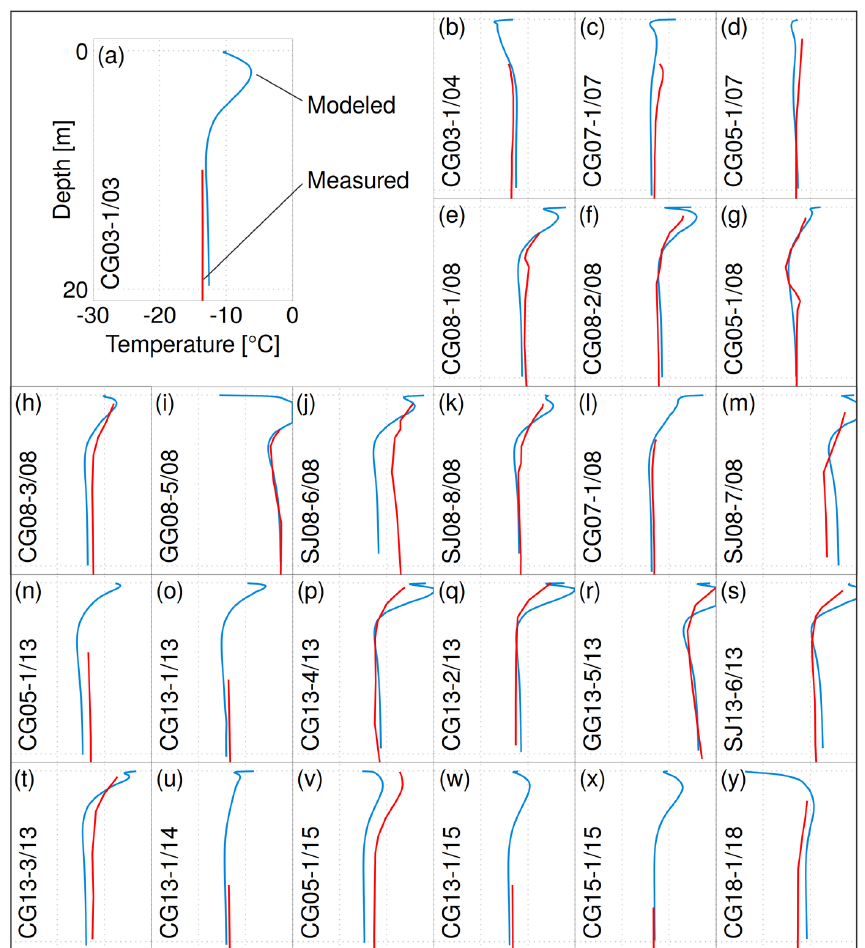
Figure 4. Measured and modeled borehole temperature profiles, sorted chronologically. Axis range is the same in all plots. The bottom depth of 20m corresponds to the deepest simulated values and to the depth of zero amplitude of the annual cycle. Profile codes follow the scheme XXYY-Z/WW, with XX location code, YY borehole year, Z borehole number, and WW year of the profile measurement (Hoelzle et al., 2011; GLAMOS, 2017). Letter codes correspond to Fig. 5.